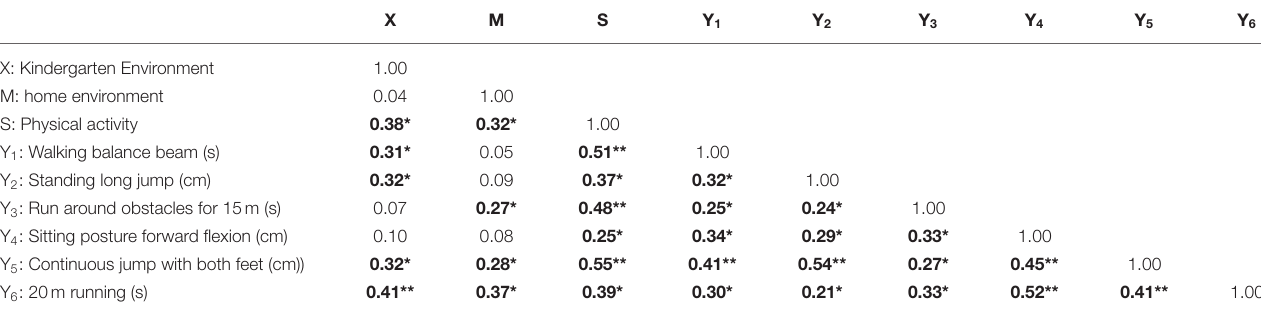
TABLE 2 | Correlation matrix between family and kindergarten environment, children’s physical activity, and health fitness indicators. X M S Y 1 Y 2 Y 3 Y 4 Y 5 Y